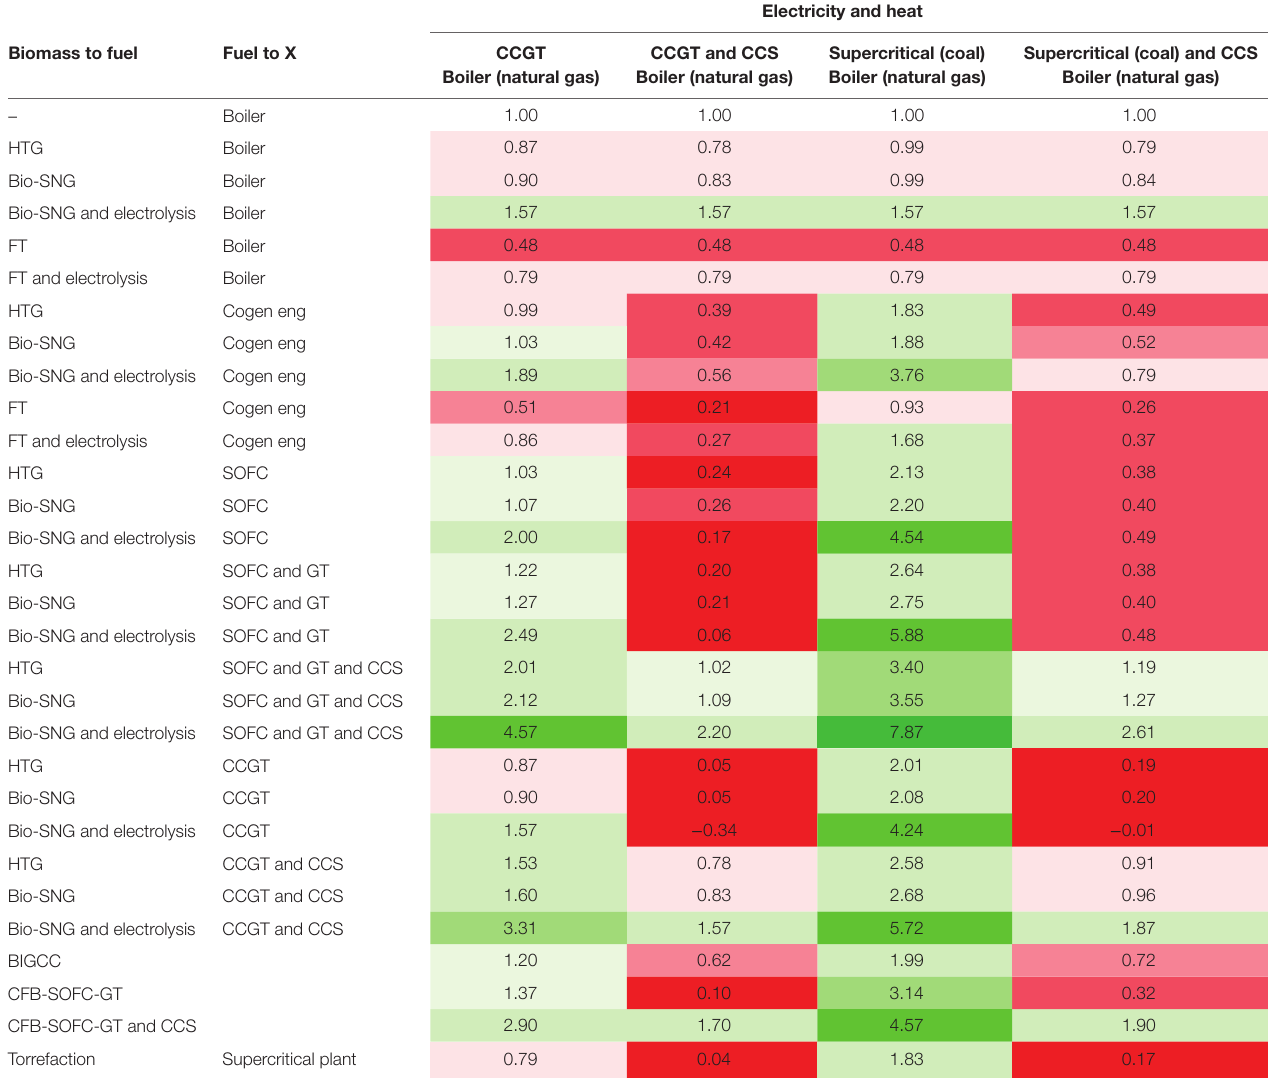
Table cells colored in shades of green correspond to solutions that have a better mitigation effect than the use of biomass in a boiler, while cells colored in shades of red represent solutions where the mitigation effect is lower.